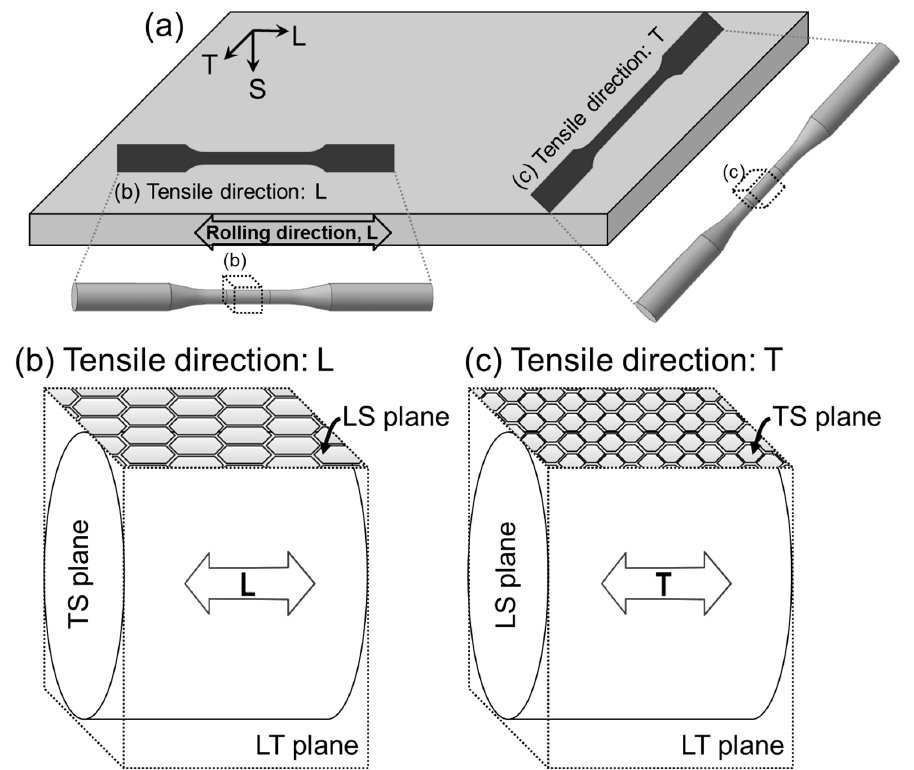
Figure 2. ( a ) Schematic diagrams of sample preparation. The samples were prepared ( b ) parallel to the rolling direction (longitudinal, L-direction); and ( c ) perpendicular to the rolling direction (transverse, T-direction).